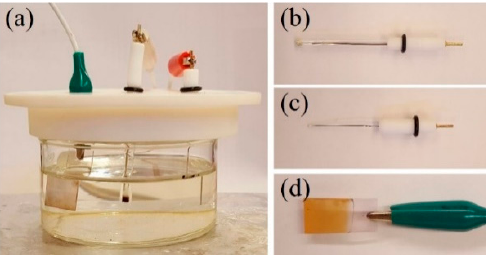
Figure 1. ( a ) Electrodeposition setup, with the reference ( b ), counter ( c ) and working ( d ) electrodes.